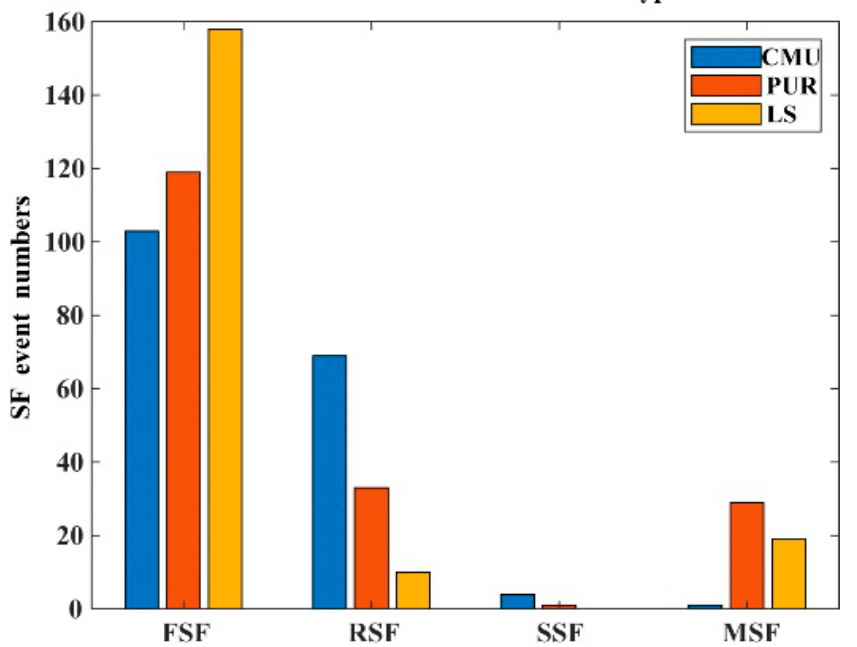
Figure 5. The numbers of SF events for different types marked by the initial type.